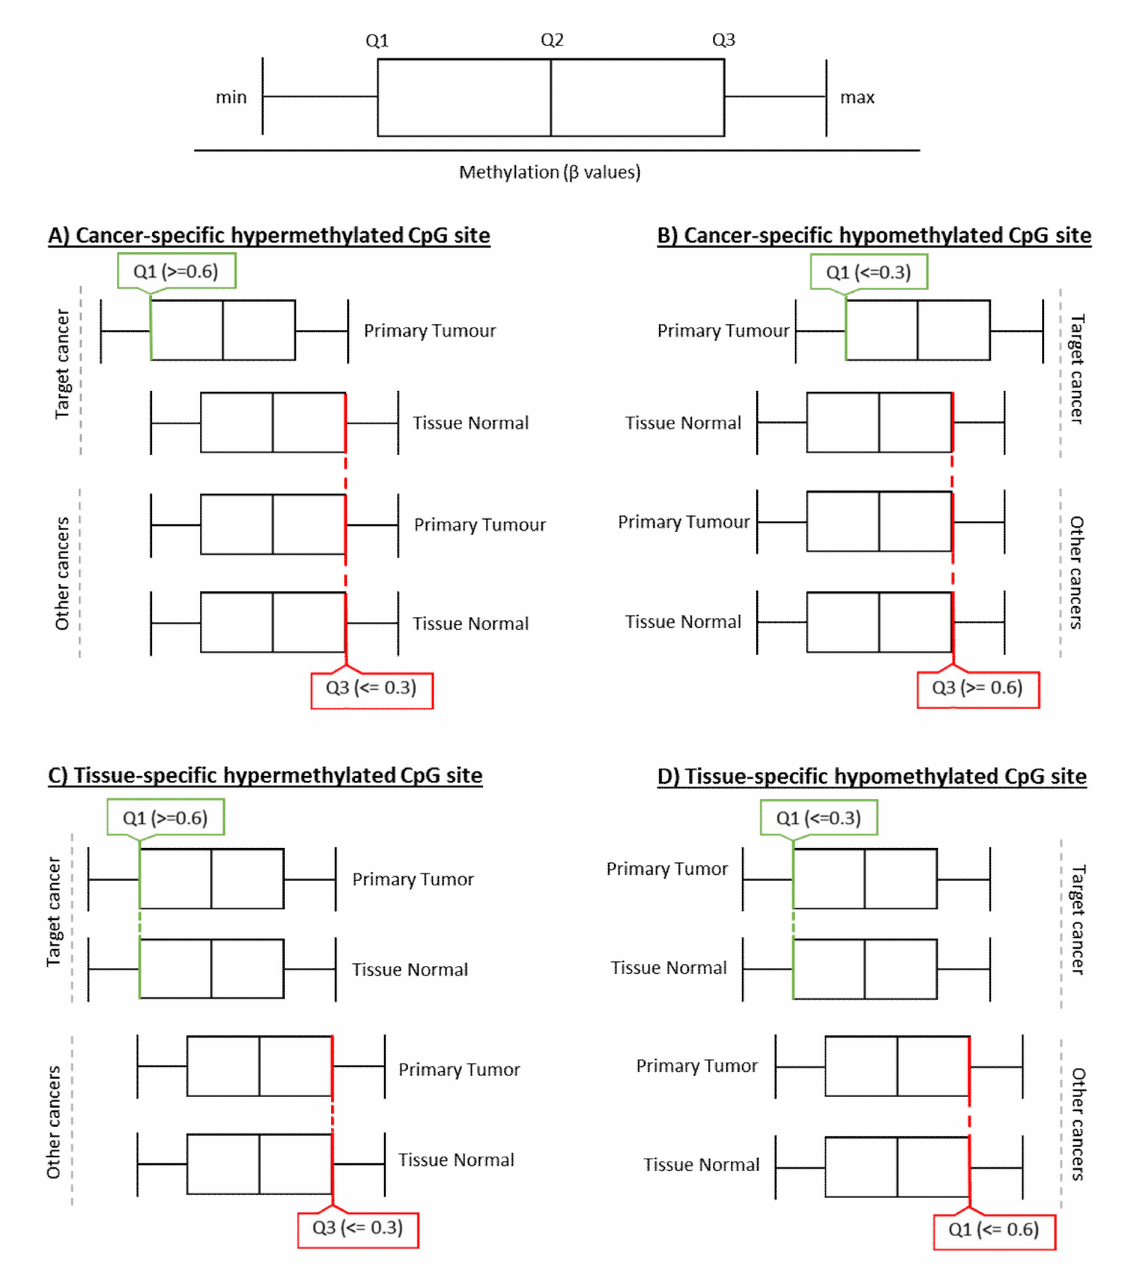
Figure 5. Overview of the Quartile Parsing methodology in the MethylMine framework. ( A ) Cancer-specific hypermethylated CpG site: more than 75% (Q1) of the primary tumor CpG beta values are above 0.6 (60% methylated), while more than 75% (Q3) of the normal tissue (target cancer), and the primary tumor and normal tissue of other cancers, are less than 0.3 (30% methylated). ( B ) Cancer-specific hypomethylated CpG site: more than 75% of the primary tumor samples of the target cancer are less than 0.3 (30% methylated), while more than 75% of normal tissue of the target cancer, and primary tumor and normal tissue of other cancers, are more than 0.6 (60% methylated). ( C ) Tissue-specific hypermethylated CpG site: more than 75% (Q3) of the normal tissue and primary tumor of the target cancer are more than 0.6 (60% methylated), ( D ) Tissue-specific hypomethylated CpG site: more than 75% (Q3) of the normal tissue and primary tumor of the target cancer is less than 0.3, and more than 75% of other cancers, are more than 0.6 (60%